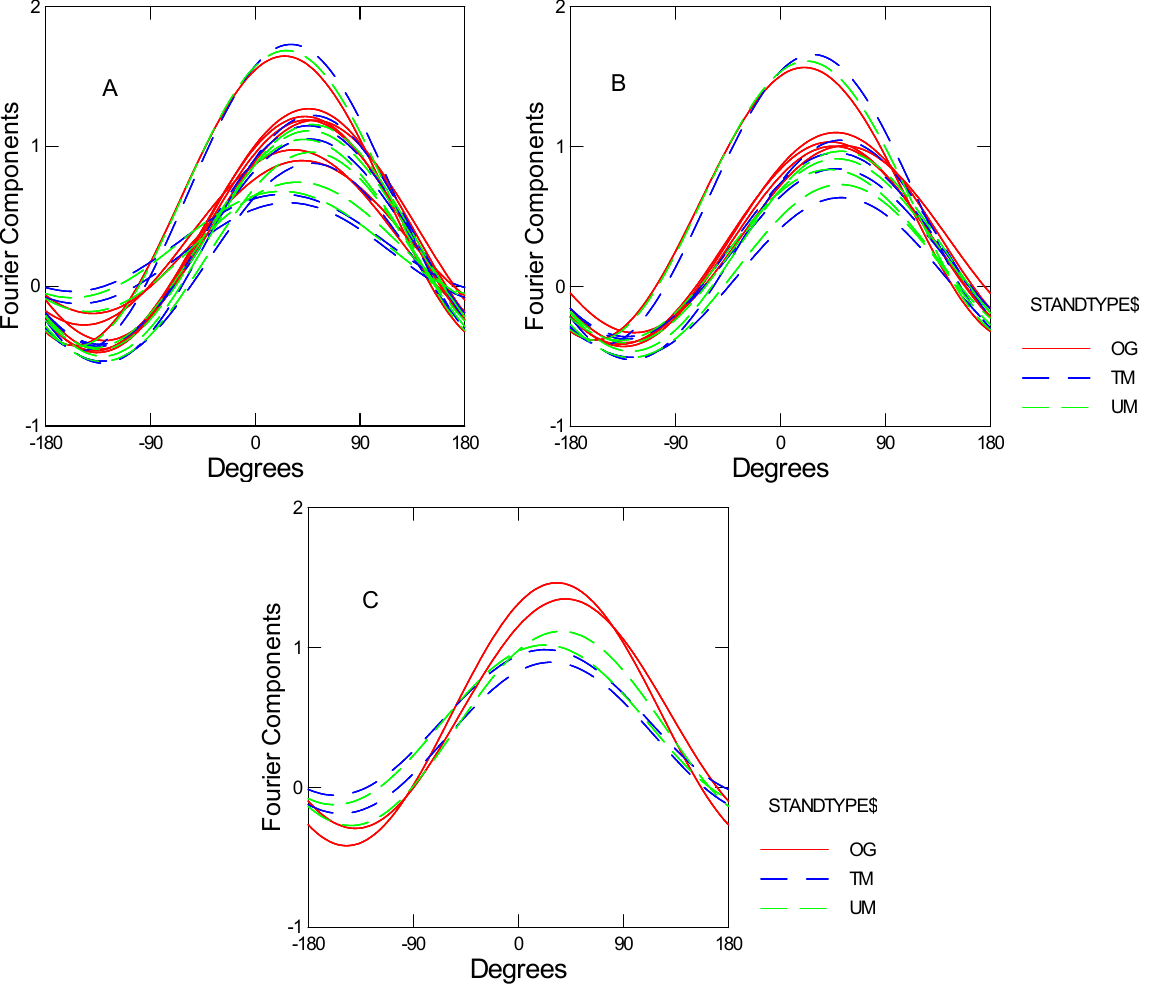
Figure 10. Andrews Fourier Plots of multivariate model 2 (Table 5; Log (AMN), Log (moisture content), Log (FF mesofauna richness)). Each curve represents one stand. AMN = anaerobic mineralizable nitrogen; FF = forest floor. ( A ) = All regions; ( B ) = Cascades and Coast ranges; ( C ) = Siskiyous. The three stands that obviously separate from the others in ( A ) and ( B ) are all from a single site in the Coast Range. That site was not included in Figure 9 (incomplete